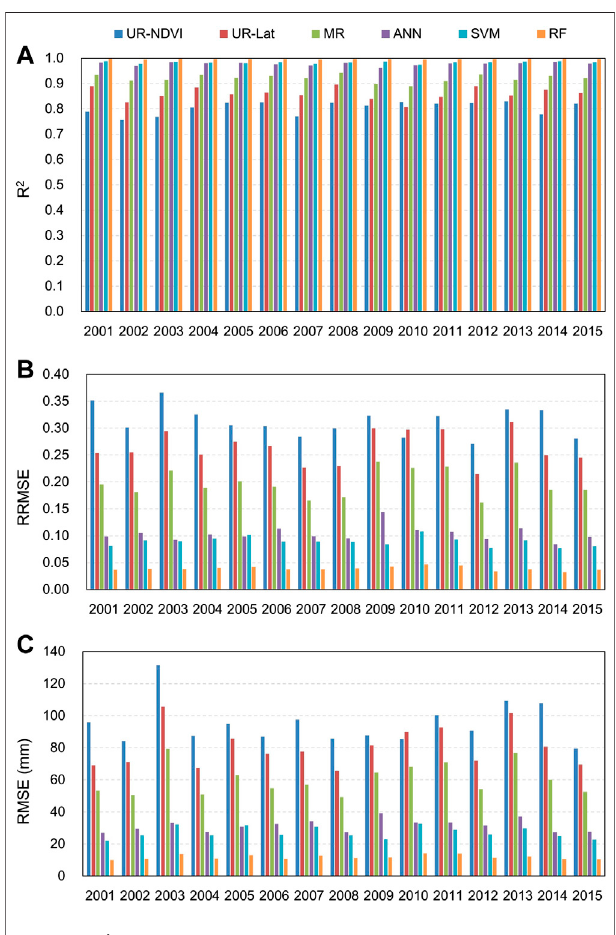
FIGURE 3 | Evaluation results of different downscaling methods using theoriginalGPMIMERGV06Bdataateachyearfrom2001to2015 (A-C) R2, RRMSE, and RMSE.